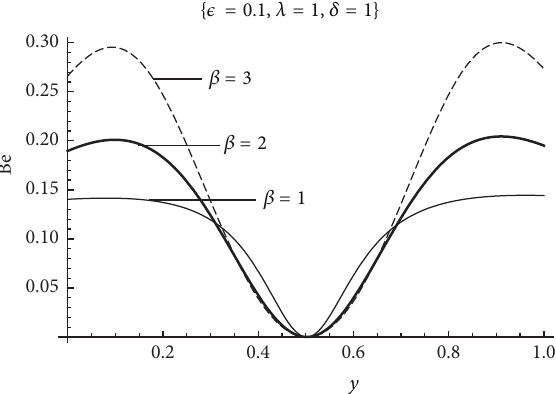
Figure 8: Bejan number at different viscous heating